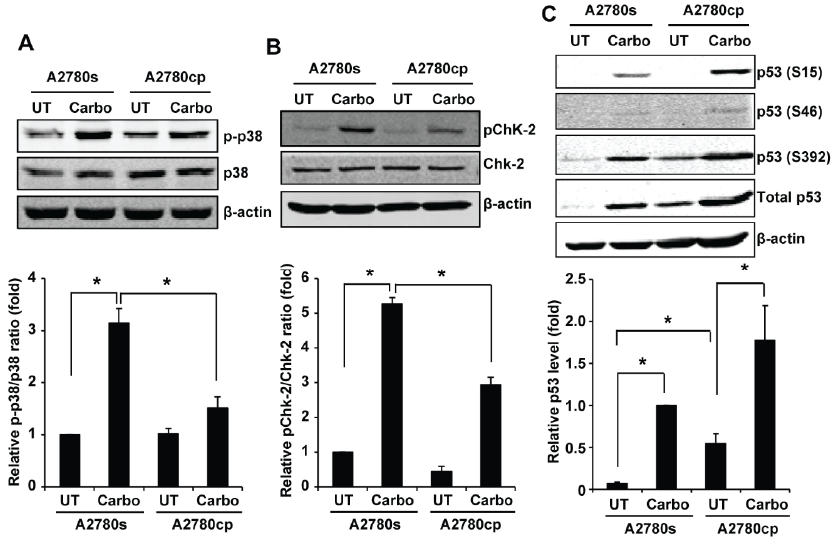
Figure 1. Validation of the kinase array data by Western blotting. A2780s and A2780cp cells were left untreated or treated with 50 μ M carboplatin for 24 h, and the whole cell lysates were collected for Western blotting to measure total and phosphorylated p38 ( A ), Chk ‐ 2 ( B ), and p53 ( C ). β‐ actin was untreated or treated with 50 µ M carboplatin for 24 h, and the whole cell lysates were collected for used as the loading control. ( A , B ) Phosphorylated p38 (p ‐ p38) and Chk ‐ 2 (pChk ‐ 2) were quantified Western blotting to measure total and phosphorylated p38 ( A ), Chk-2 ( B ), and p53 ( C ). β -actin was used as the loading control. ( A , B ) Phosphorylated p38 (p-p38) and Chk-2 (pChk-2) were quantified using Odyssey imaging software and normalized against total p38 and Chk-2. Relative p-p38/total p38 and pChk-2/total Chk-2 ratio (fold change) were shown as mean ± SE of four and three independent experiments, respectively, with that in untreated A2780s cells designated as 1. ( C ) Total p53 was quantified using Odyssey imaging software and normalized against β -actin and expressed as relative fold change with that in carboplatin-treated A2780s cells designated as 1. The relative p53 level was shown as mean ± SE of three independent experiments. * Significantly different ( p <